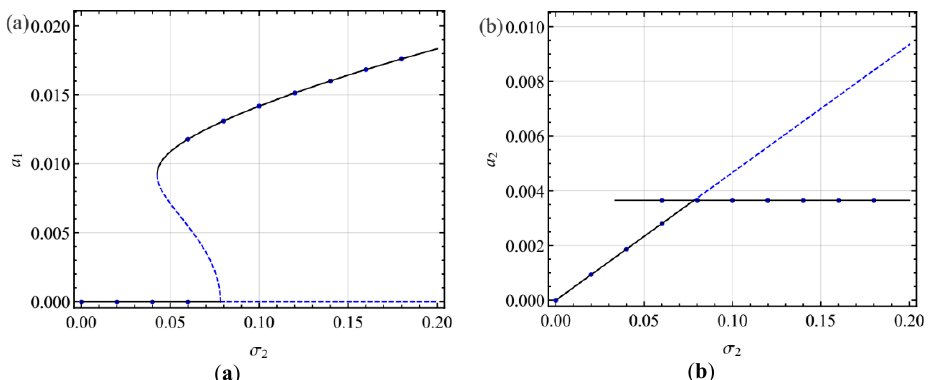
Figure 14. Comparison of the frequency-response curves of the primary resonance of the second mode; ( a ) the first mode, ( b ) the second mode.